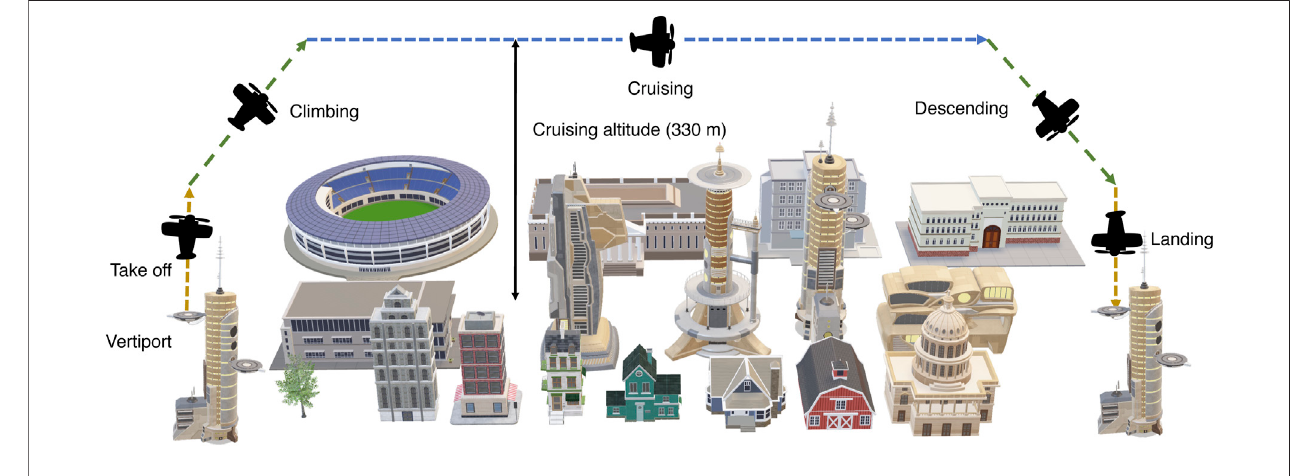
FIGURE 3 | Flight plan of an eVTOL in a metropolitan area.